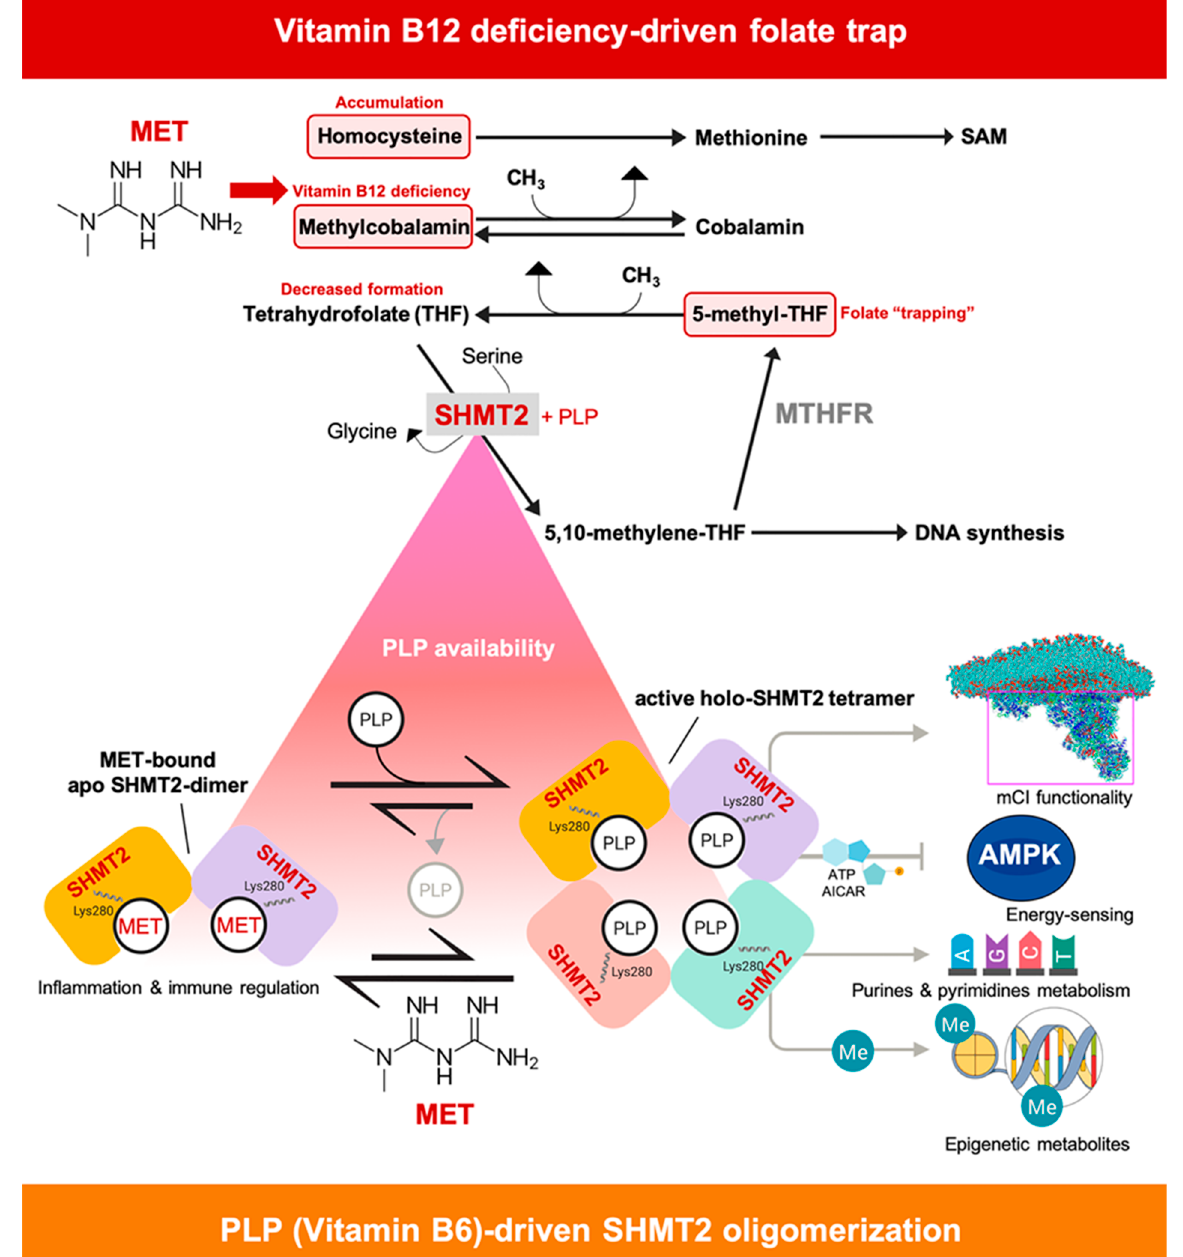
Figure 9. Metformin and SHMT2 functioning: a working model. The pharmacological capacity of metformin to operate as a PLP-competitive inhibitor of the oligomeric state of mitochondrial SHMT2 might offer a new perspective for understanding the anti-cancer mechanism of action of metformin. First, mitochondrial SHMT2 is the key channeler of serine-derived carbon into the cytoplasmic and mitochondrial 1C pools of THF-based cofactors that are required not only for nucleotide synthesis but also for mitochondrial respiration, including assembly of the mCI, tRNA formylation-driven translation of mitochondrially encoded proteins, and methylation transfer reactions in cancer cells. Second, the selective advantage provided by the (SHMT2) mitochondrial 1C metabolism versus the (SHMT1) cytosolic pathway is based on the ability of the SHMT2-dependent rate of mitochondrial serine-to-formate catabolism to regulate a master metabolic switch in nucleotide and AMPK-sensed energy metabolism. Third, the inactive apo-SHMT2 dimer is recognized as an unexpected driver of immune signaling capable of promoting inflammatory cytokine signaling via interaction with the deubiquitylating BRCC36 isopeptidase complex